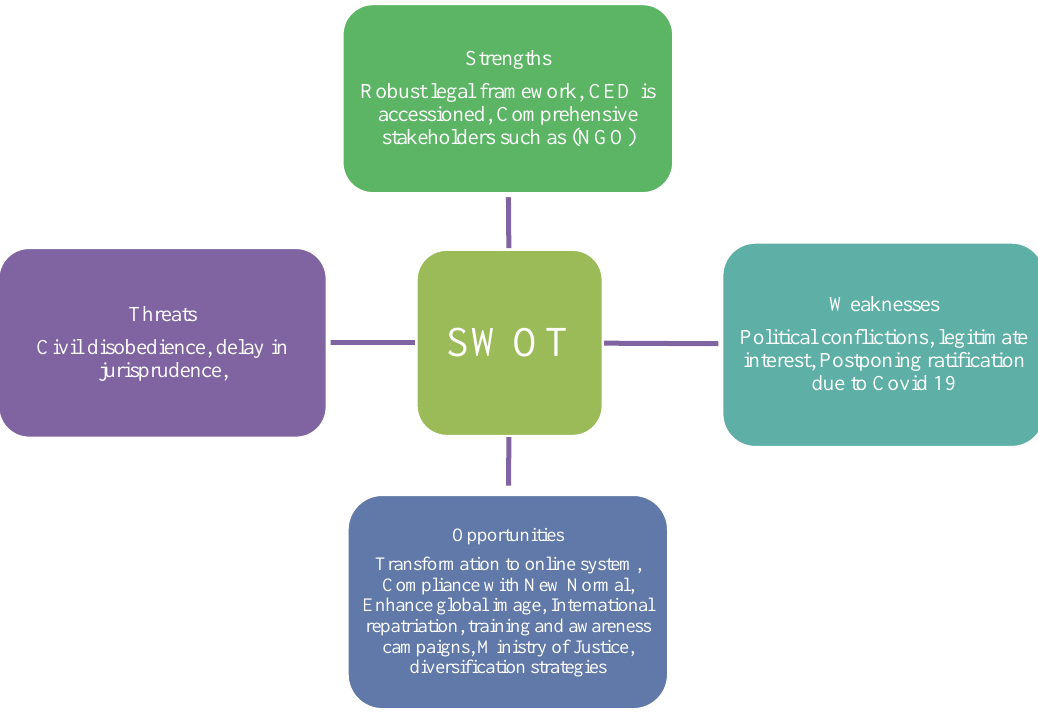
Figure 8. SWOT analysis for the